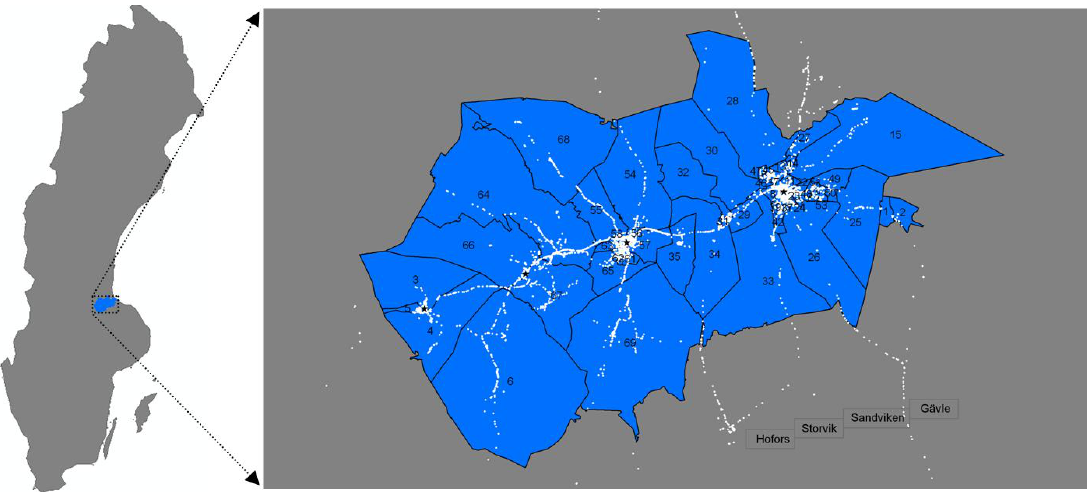
Figure 1. A map of the city districts overlaid with one day static points (SPs) (Note: The white dots represent the SPs on 1 October 2007; four black stars denote the central location of four cities or towns; and each city district is numbered from 1 to